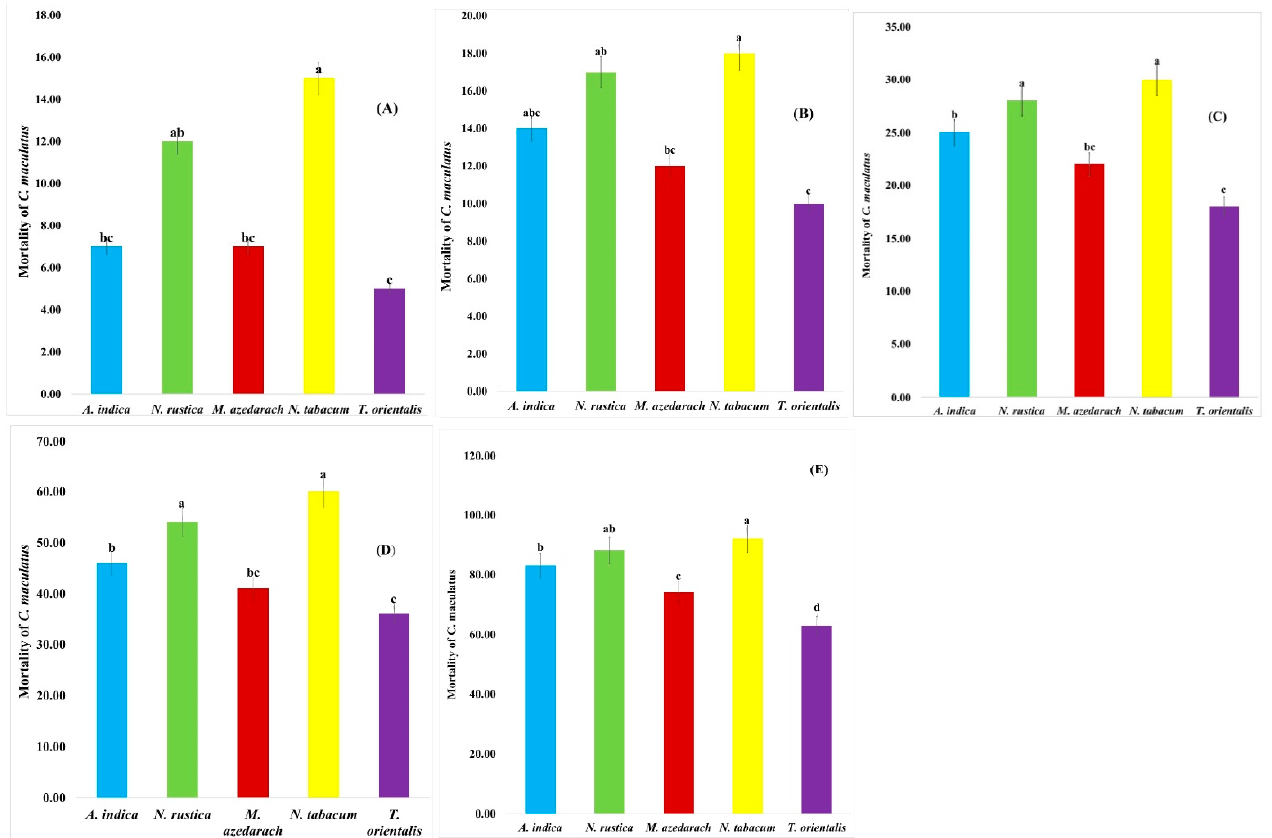
Figure 2. Mean percent Mortality of C. maculatus treated with plant extracts after ( A ) 24 h, ( B ) 48 h, ( C ) 72 h, ( D ) 168 h and ( E ) 336 h exposure (Topical effect). (a, b, c, d put over the bars indicating that different letters are significantly different from each other at 0.5% level of significance).